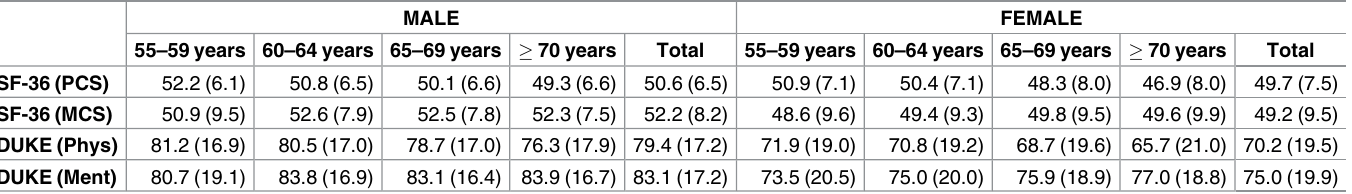
Table 3. Outcomes related to mental health, physical health and health-related quality of life (HRQoL) by gender and age groups.